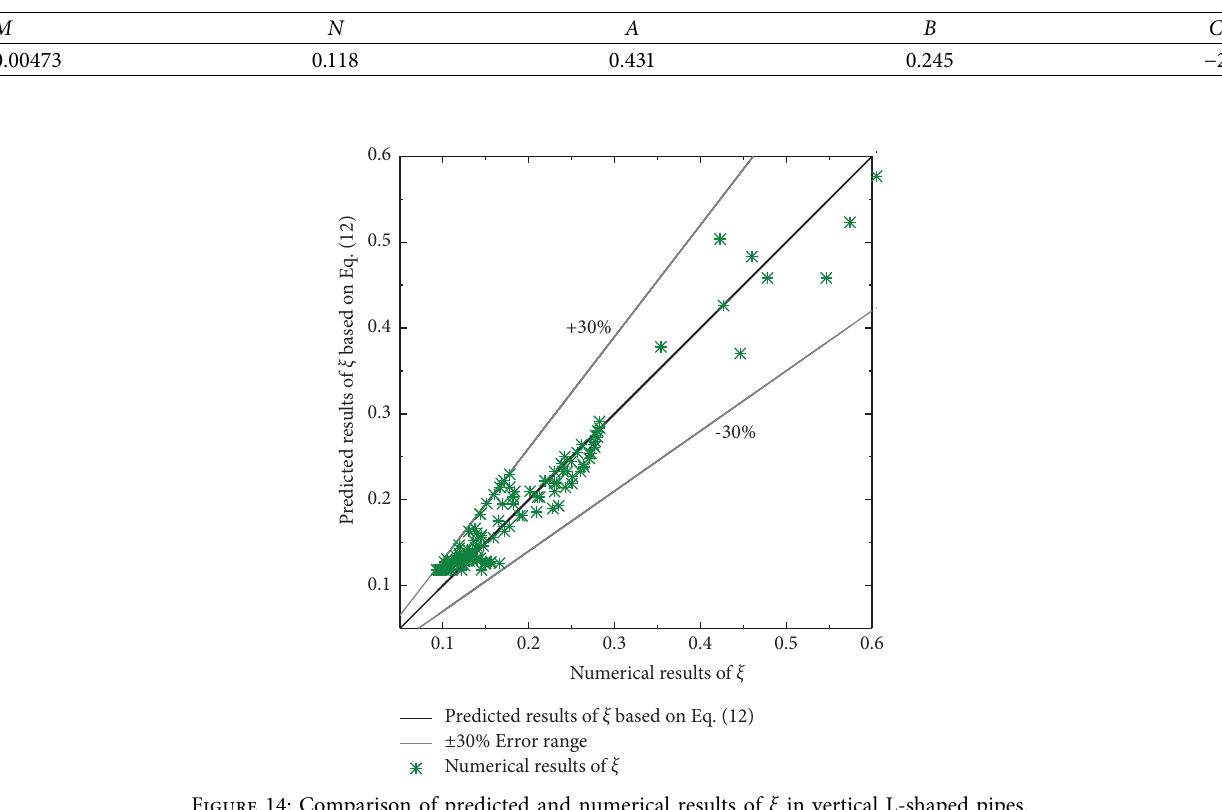
Figure 13: Relationship curves of ξ with H/D under three diferent fow directions in Z-shaped pipes. Horizontal dashed lines indicate two times ξ of the L-shaped pipes under the same numerical parameters. Table 3: Te values of the constants in equation